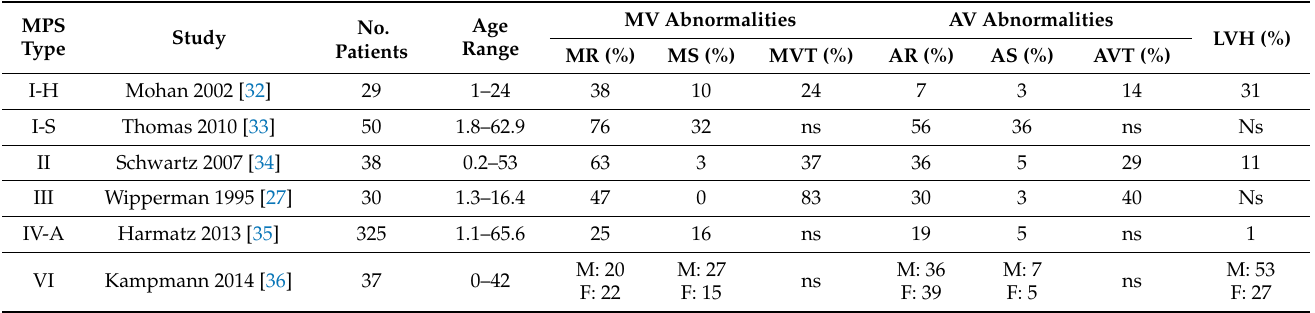
Table 2. Cardiac abnormalities in children and adults with MPS from reported